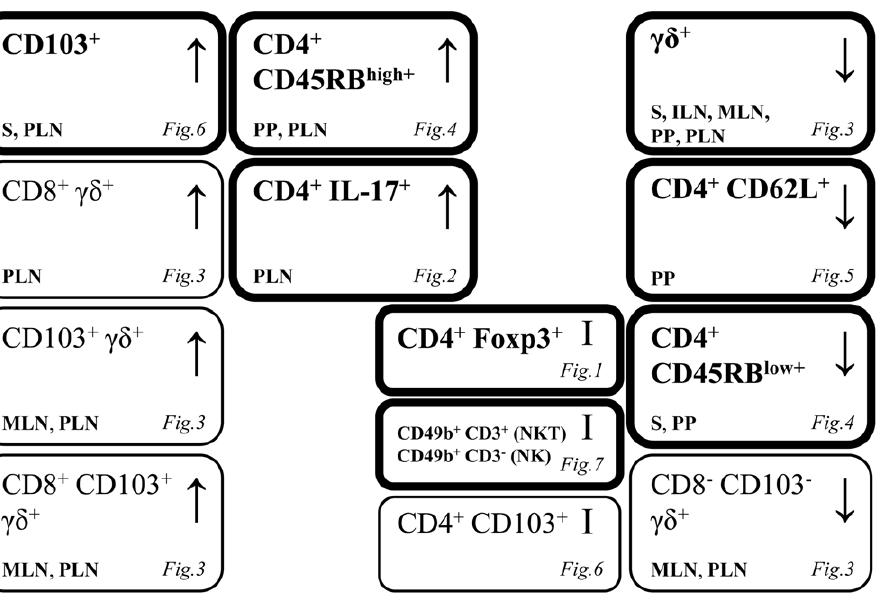
Figure 8. Summary of changes in T cells (CD3 + ) subsets and cellular markers in BALB/c mice receiving the gluten-containing STD diet compared to the GF diet. Spleen (S); inguinal lymph nodes (ILN); mesenteric lymph nodes (MLN); Peyer’s patches (PP) and pancreatic lymph nodes (PLN). Significant diet-induced changes within specific lymphoid compartment are indicated in each box. q : Increased proportion in animals receiving the gluten-containing STD diet. Q : Decreased proportion in animals receiving the gluten-containing STD diet. I: No diet-induced changes. Boxes with thin line: Subsets of T cells expressing a specific cellular marker e.g. cd T cells expressing CD103.